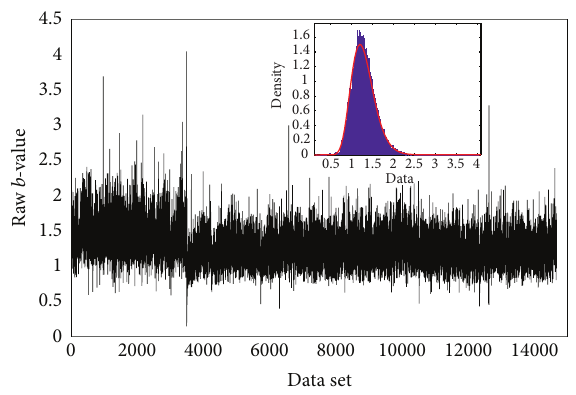
Figure 11: 𝑏 -values results for the entire data set before smoothing process for TC specimen.